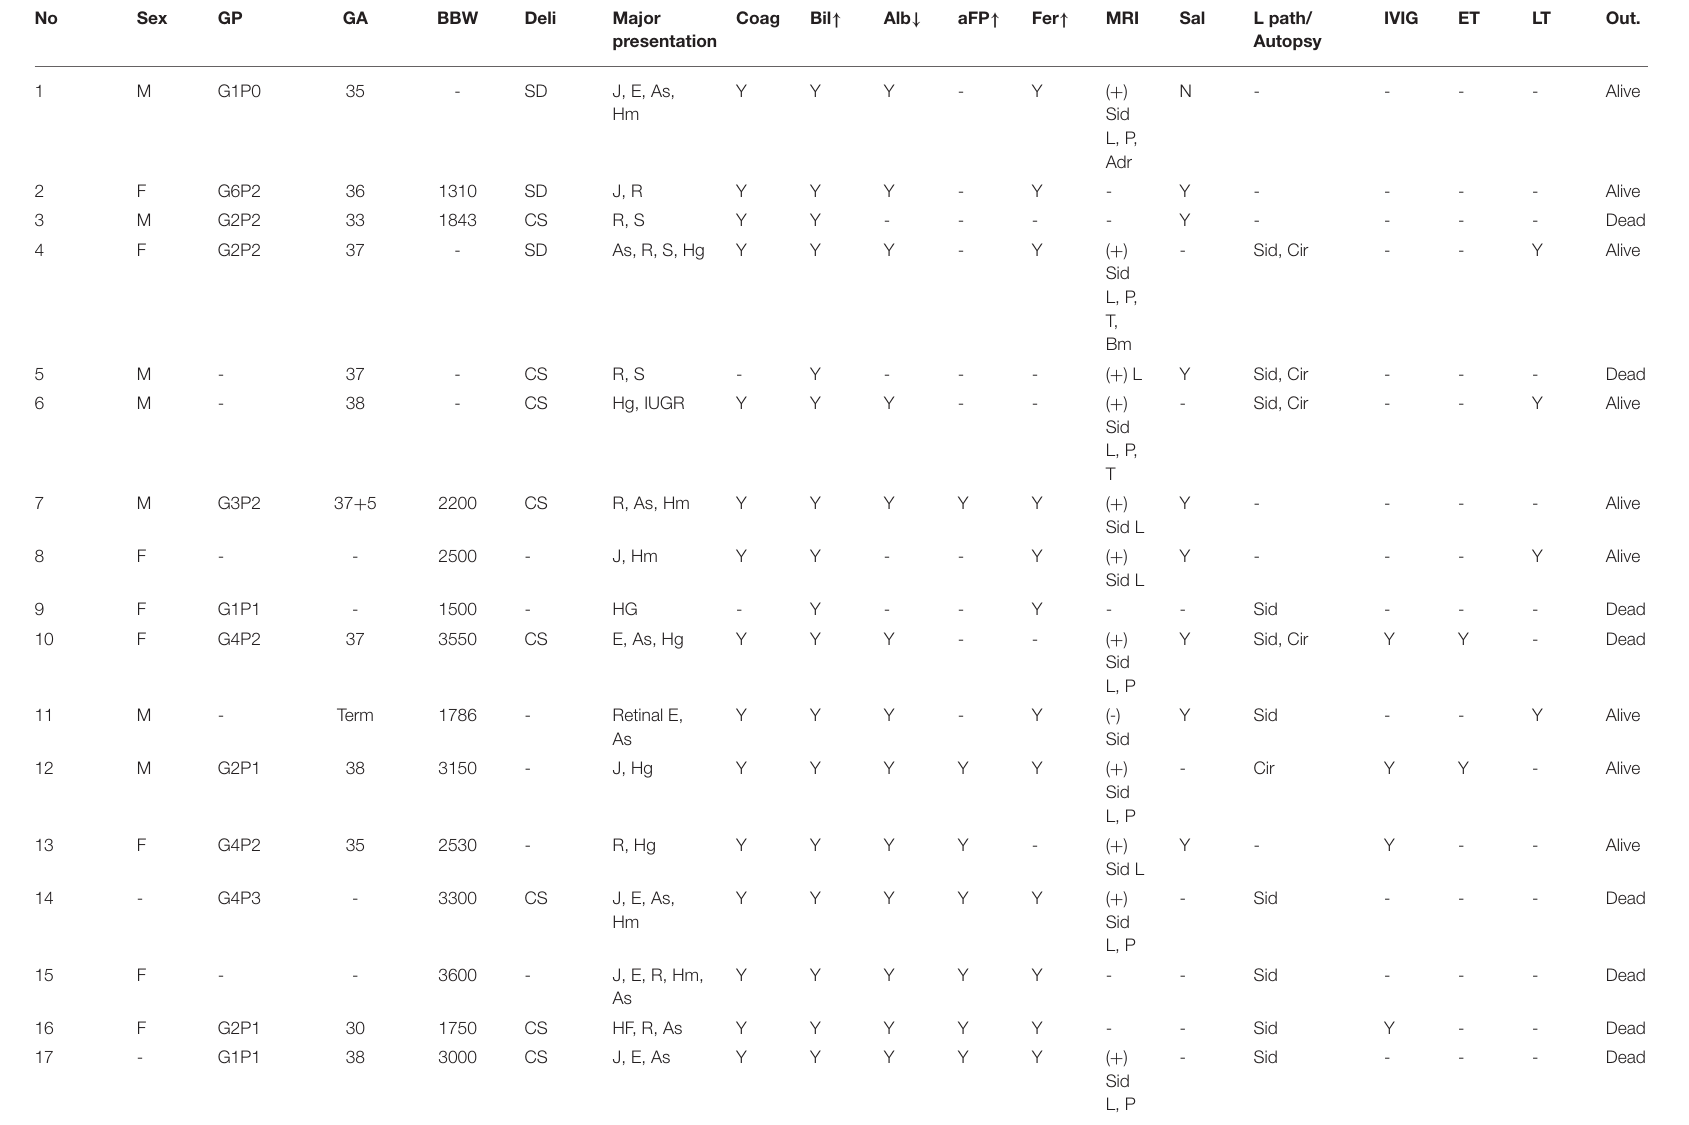
TABLE 1 | Baseline data, presentations, examination results, treatments, and outcomes of the 39